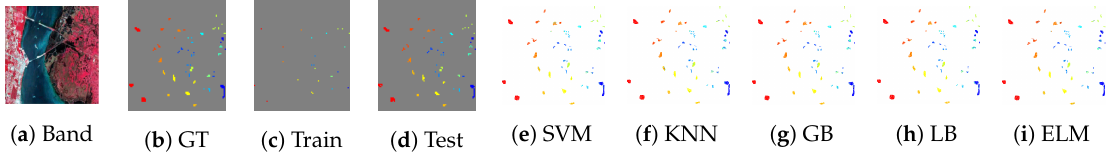
Figure 7. Kennedy Space Center: ( a ) Ground Band, ( b ): True Ground Truths, ( c ): Training Ground Truths, ( d ): Test Ground Truths, and ground truths predicted by ( e ): SVM, ( f ): KNN, ( g ): GB, ( h ): LB, and ( i ): ELM classifiers with 2% of selected training